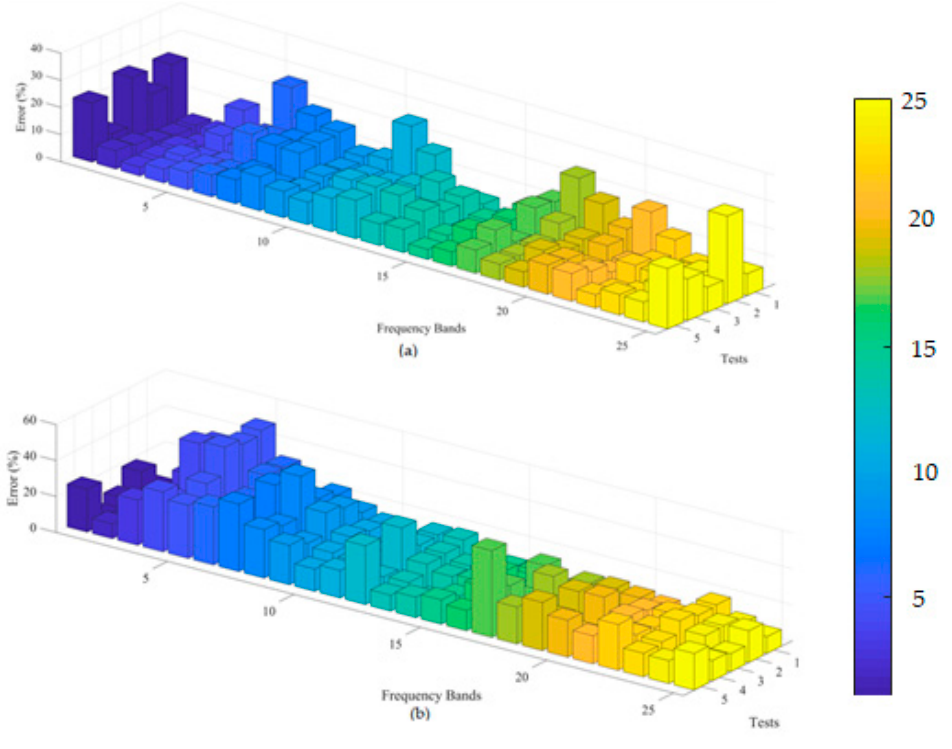
Figure 4. ( a ) Percentage error related to the frequency bands of position 1; ( b ) percentage error related to the frequency bands of position 2.